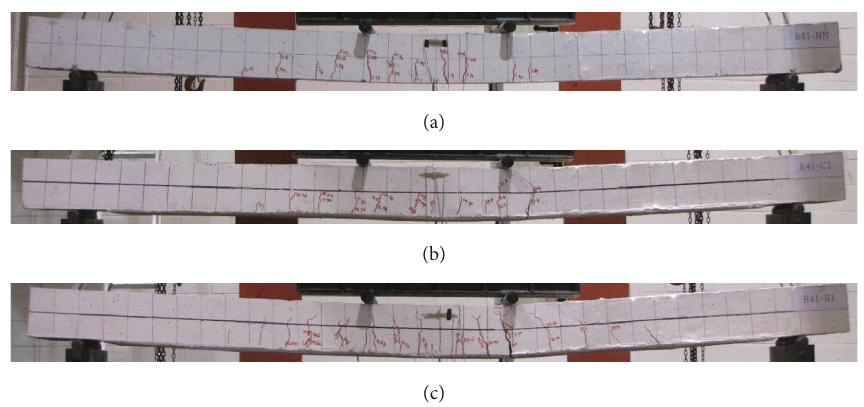
Figure 4: Deformed shapes of specimens after testing. (a) R41-NN. (b) R41-C1. (c) R41-B1.